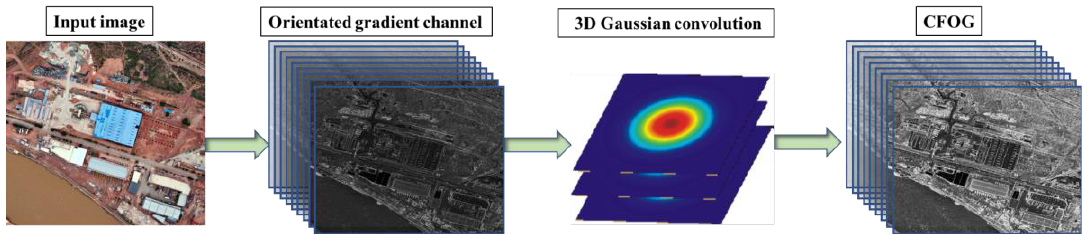
Figure 5. Construction of the CFOG